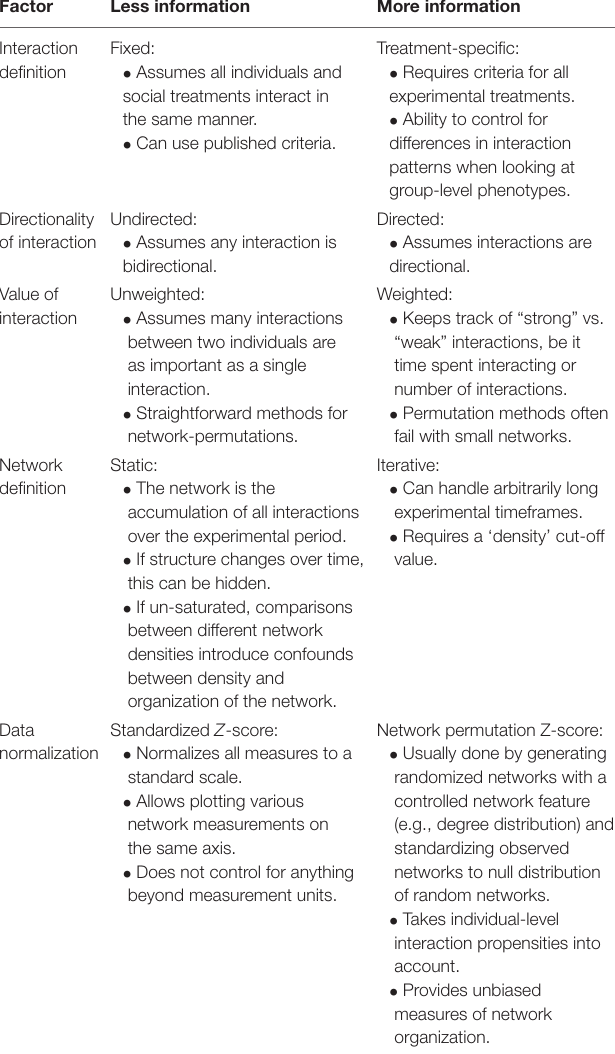
TABLE 4 | Summary of the advantages and disadvantages involved in simplistic network analyses with fewer parameters (less information column) compared to more complex analyses that require more input but controls more confounds (more information